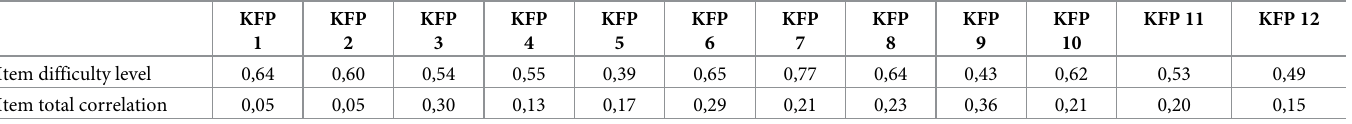
Table 1. Item difficulty